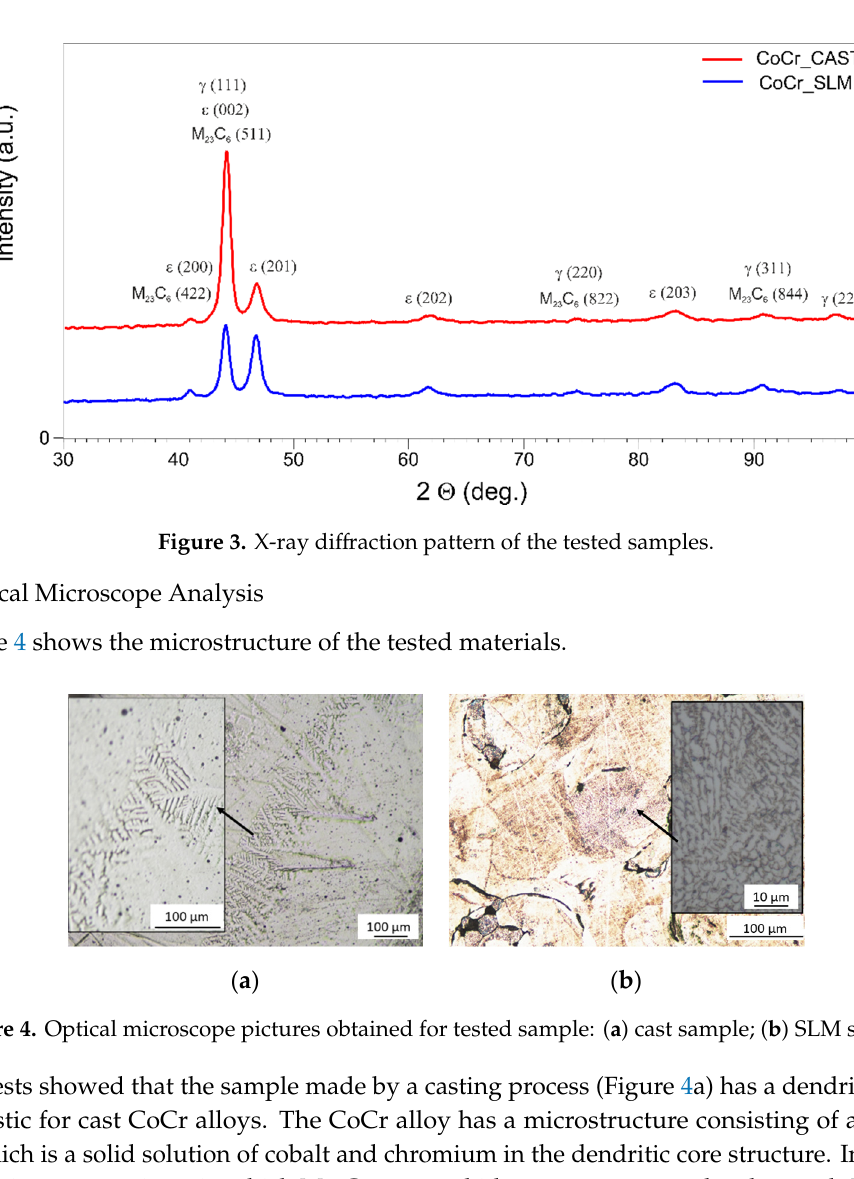
Figure 3. X-ray diffraction pattern of the tested samples.